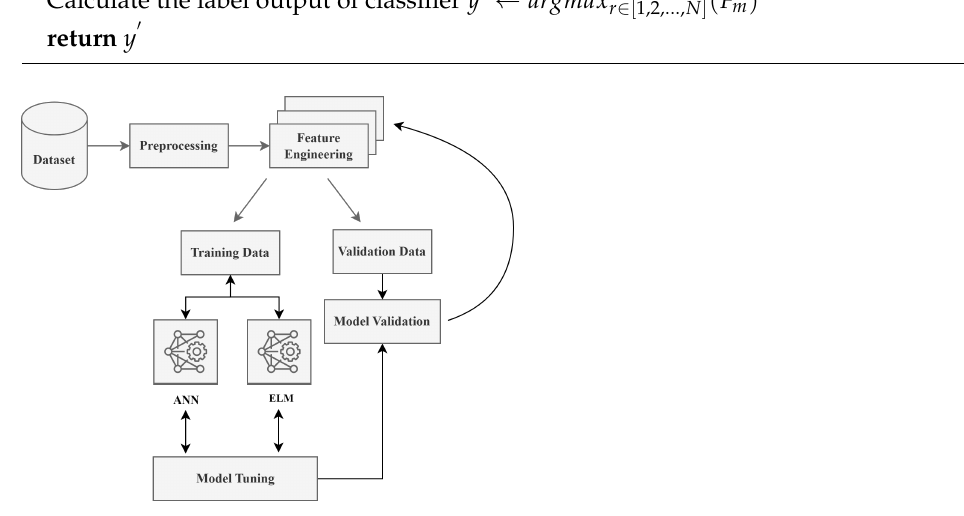
Figure 9. Machine learning implementation pipeline. SCADA